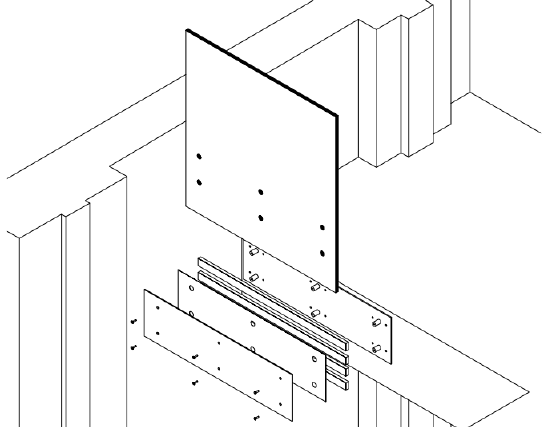
Fig. 12 Detail of the connection of the lateral parapet to the slab.